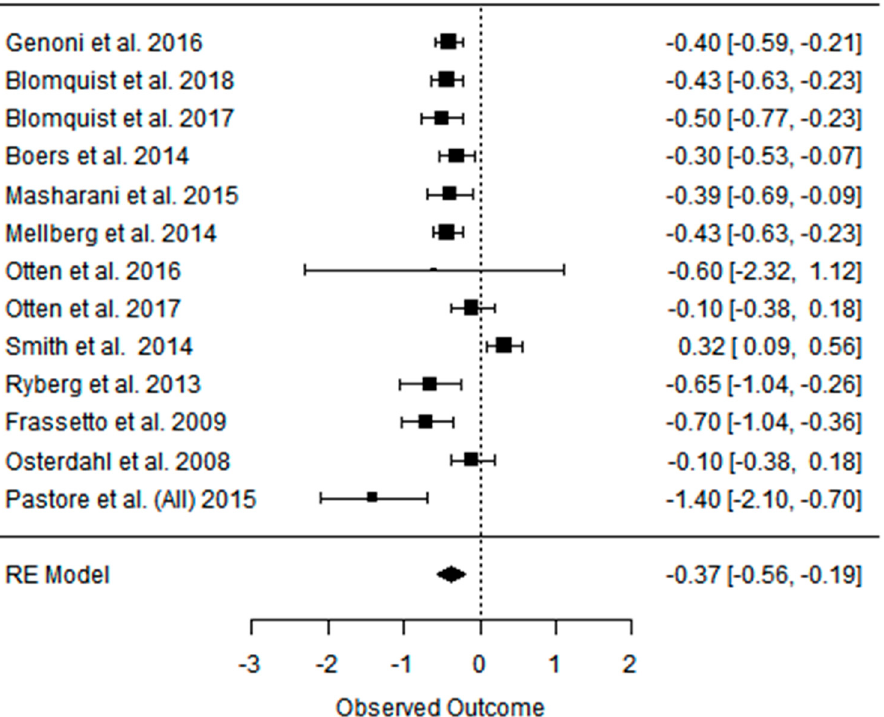
Figure A23. Forest plot of the effect of a PDs on LDL-C in the short term (weighted mean difference).